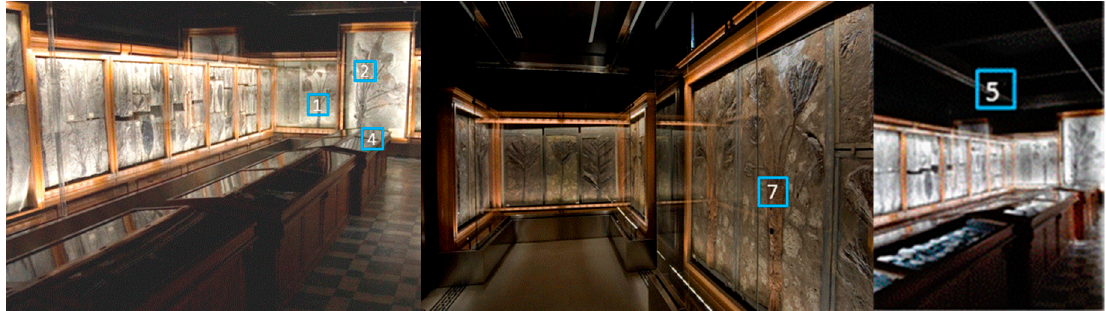
Figure 4. Some monitoring points inside the Hall of Palms.